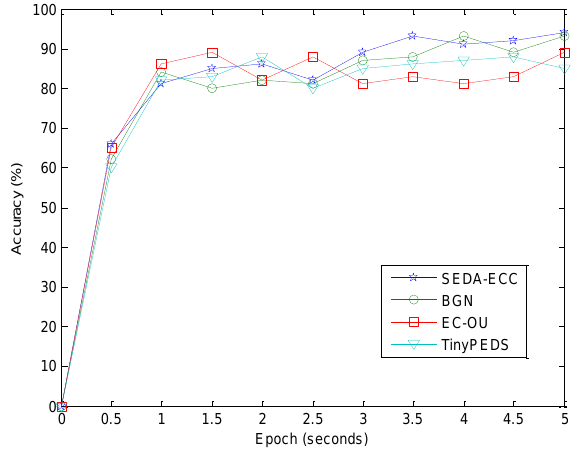
Figure 9. The comparison of accuracy with respect to different time